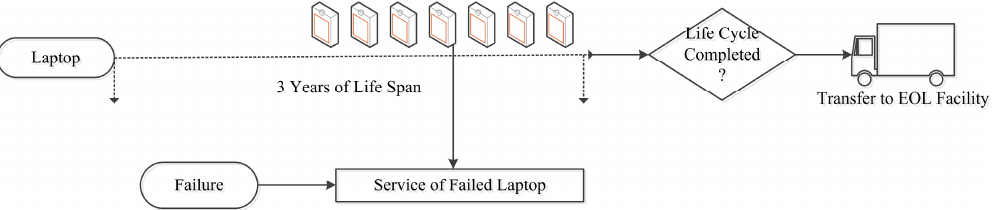
Figure 2. Life cycle outlook of laptops.